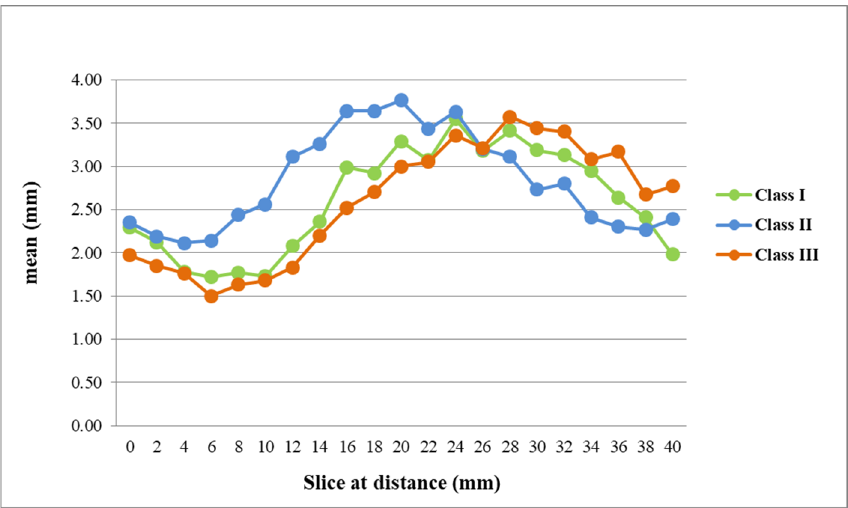
Figure 3. The mean B value (buccal bone marrow distance) in the three skeletal patterns.